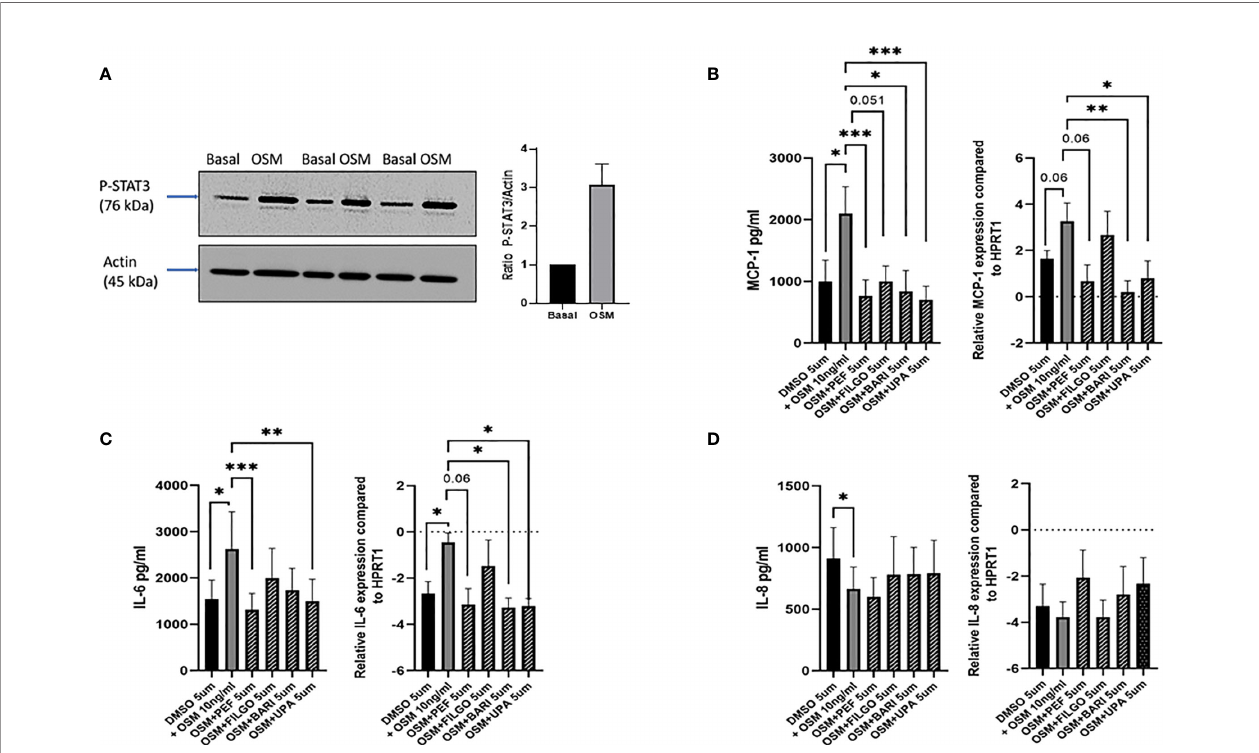
FIGURE 1 | Effect of JAKi on the OSM driven expression of pro-in fl ammatory mediators in PsAFLS. (A) Representative western blot images and bar graph showing pSTAT3 expression in PsAFLS stimulated with/without OSM for 24 h. (B – D) PsAFLS were treated with JAKi (5 µM) or DMSO (5 µM) for 1 h and stimulated with OSM (10 ng/ml) for 24 h. Bar graphs demonstrating secretion by ELISA (n=7) and gene expression by real-time PCR (n=4-5) for MCP-1 (B) IL-6 (C) and IL-8 (D) . Values expressed ± SEM. * p <0.05, ** p <0.01, *** p <0.001 signi fi cantly different from DMSO+OSM